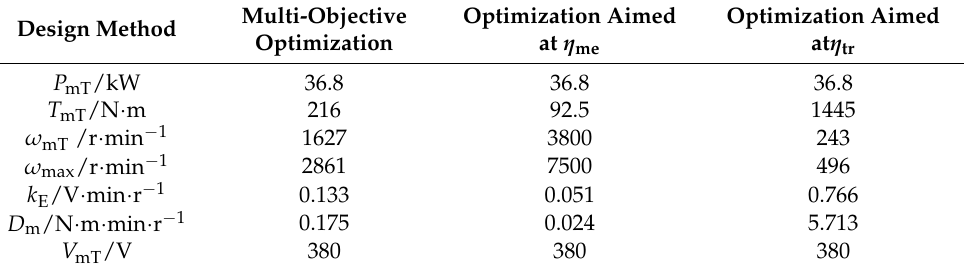
Table 1. Drive motor parameters are designed by different